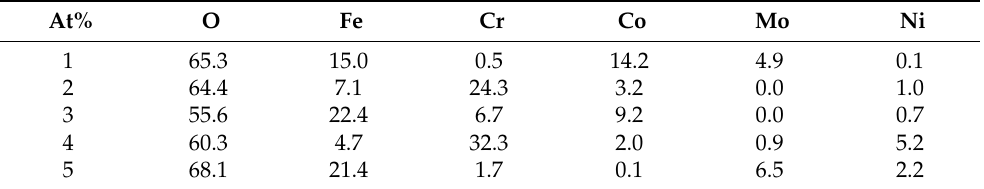
Figure 5. Surface morphologies of the FeCoNiCrMo coatings after oxidation at 1100 °C for 15 min ( a ), 30 min ( b ), and 60 min ( c ) in a steam environment. Table 4. EDS results of the FeCoNiCrMo coatings after oxidation at 1100 °C for 15, 30, and 60 min in a steam environment.